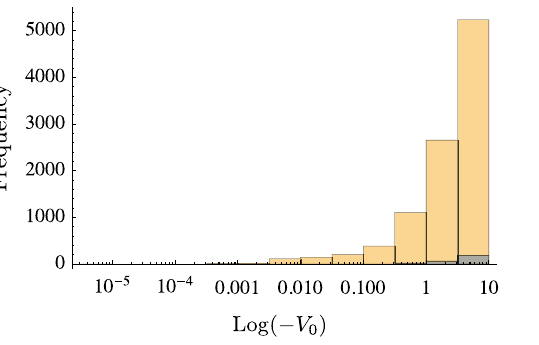
Fig. 3 Histogram of the stable vacua with random fluxes generated by the GA (blue bars) and by the ANN + GA (yellow bars). Intersection of blue and yellow bars appears as gray bars. Left: criterion I. Right: